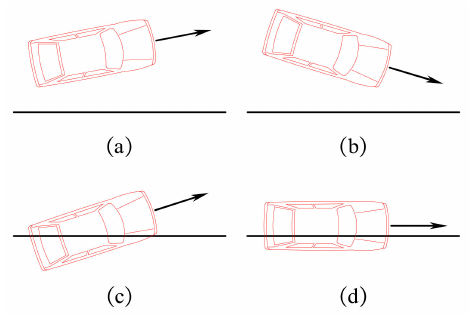
Figure 15. Schematic diagram of the position of the vehicle under different lateral errors and yaw errors. ( a ) The lateral error is large, and the vehicle heading deviates from the path. ( b ) The lateral error is large, and the vehicle heading points to the path. ( c ) The lateral error is small, and the vehicle heading deviates from the path. ( d ) The lateral error is small, and the vehicle heading points to the